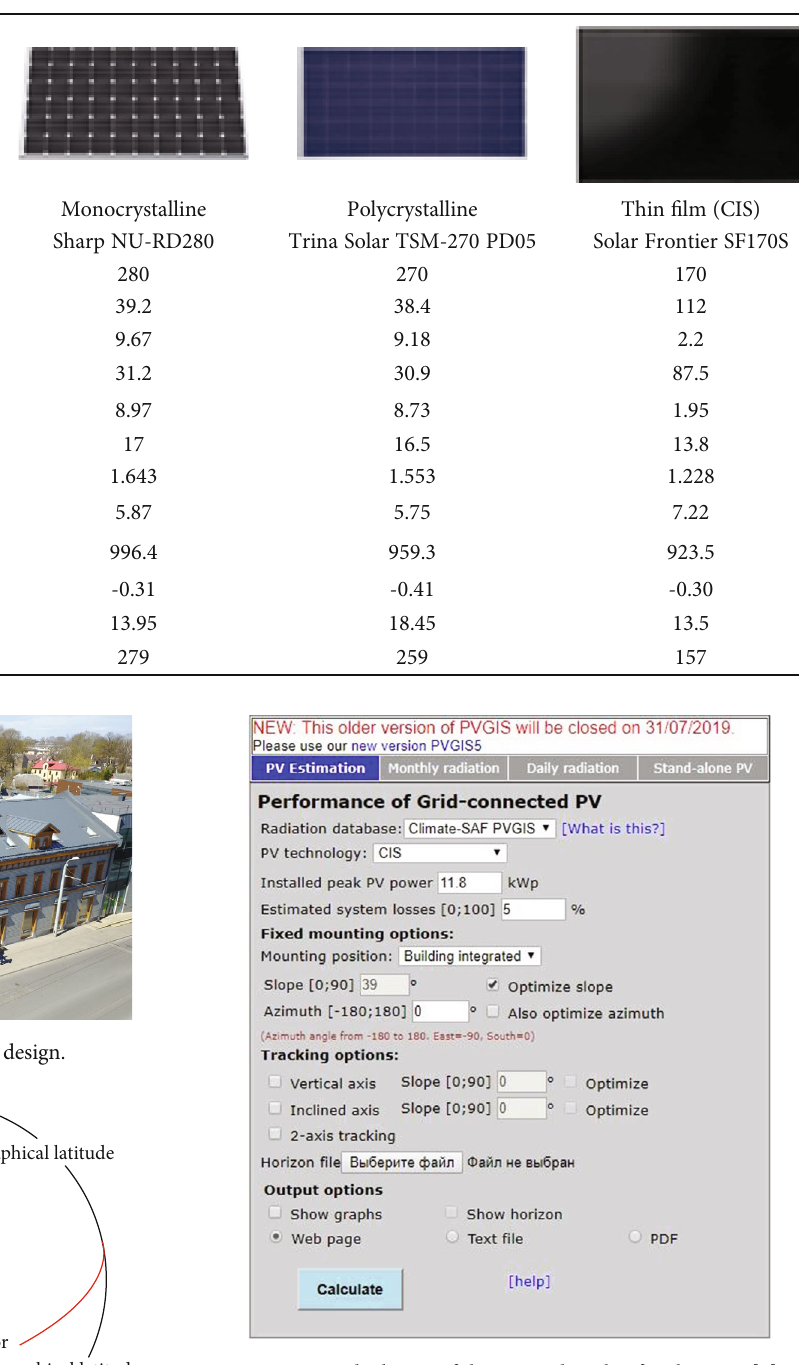
Figure 5: Calculation of the optimal angle of inclination